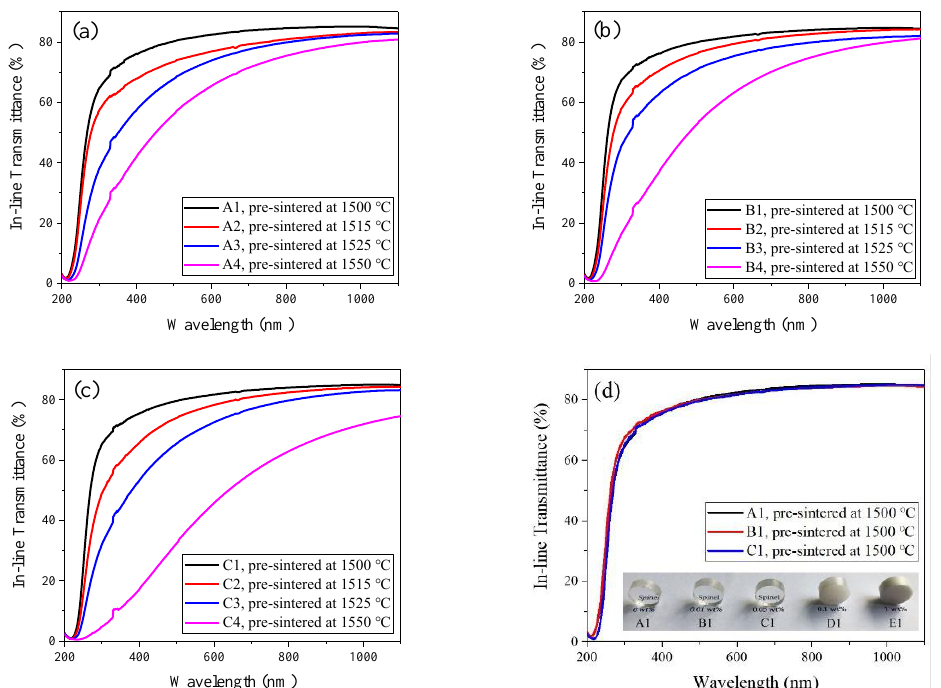
Figure 3. In-line transmittance of 1550 °C HIPed samples as a function of pre-sintering temperature (Numbers 1–4 represent samples pre-sintered at 1500, 1515, 1525, and 1550 °C, respectively): ( a ) A; ( b ) B; ( c ) C; ( d ) optimal in-line transmittance with respect to different contents of zirconia. The inset pictures show the appearance of samples A1 to E1 from left to right, respectively. All samples are 14 mm in diameter and 5 mm in thickness.